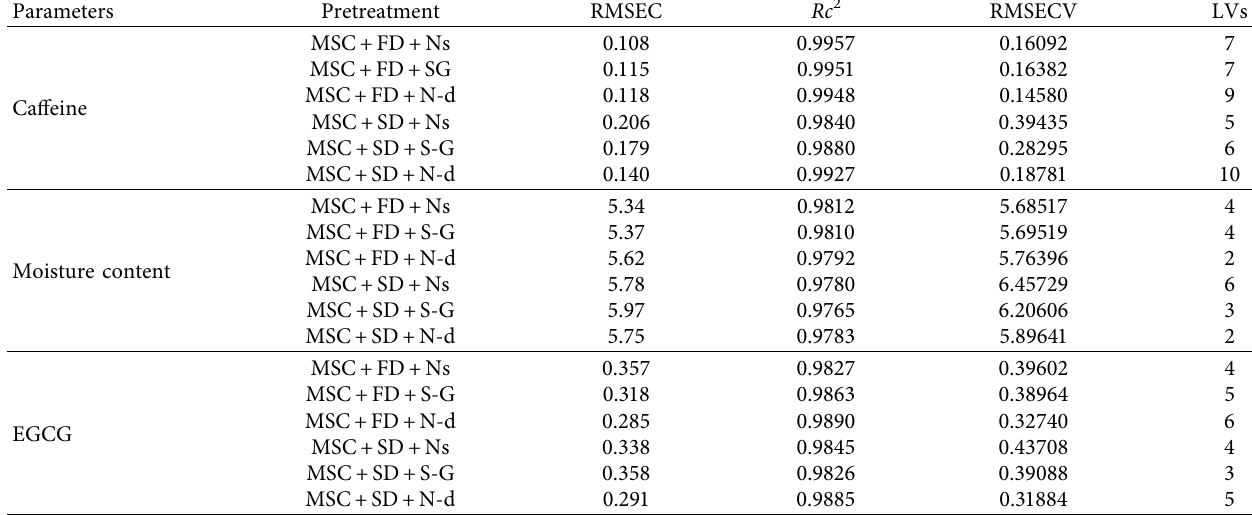
Table 3: Results of different spectral pretreatment methods.